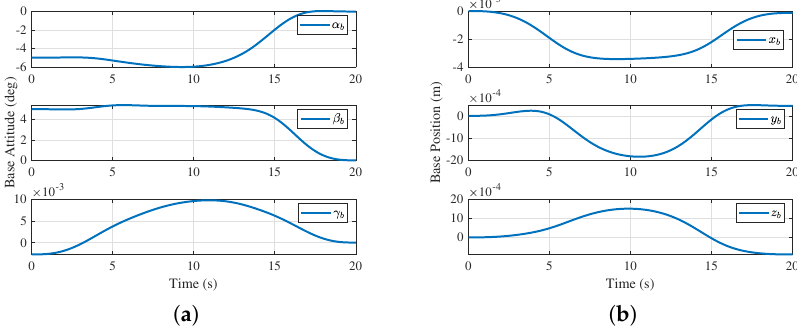
Figure 16. Pose variation of UAV base, where ( a ) UAV attitude, and ( b ) UAV